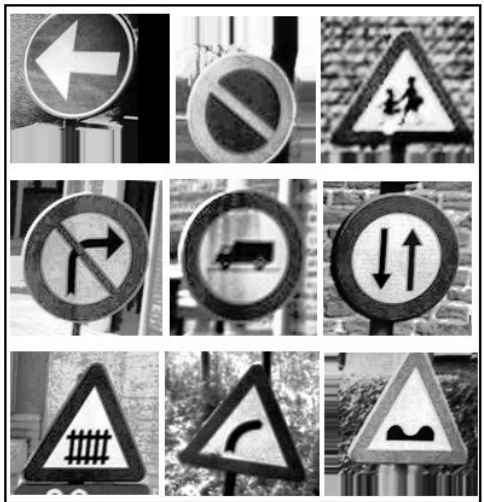
Figure 5. Sample images of the BTSD dataset.